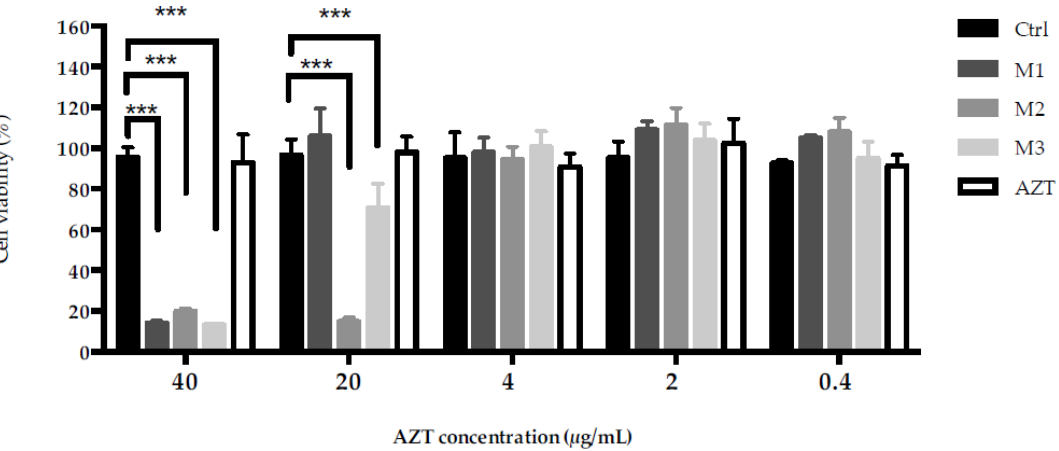
Figure 7. Fibroblasts viability (%) after 24 h of incubation at 37 °C with loaded microemulsions and AZT solution at different drug concentrations. The values denote the mean ± S.D. (n = 4). All treatments were analyzed against control (Ctrl), *** p < 0.001.